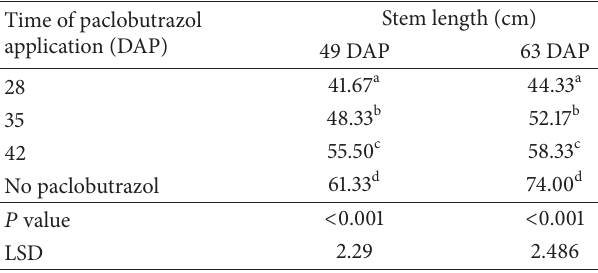
Table 2: Effect of time of paclobutrazol application on potato stem length (cm) at 49 and 63 DAP.